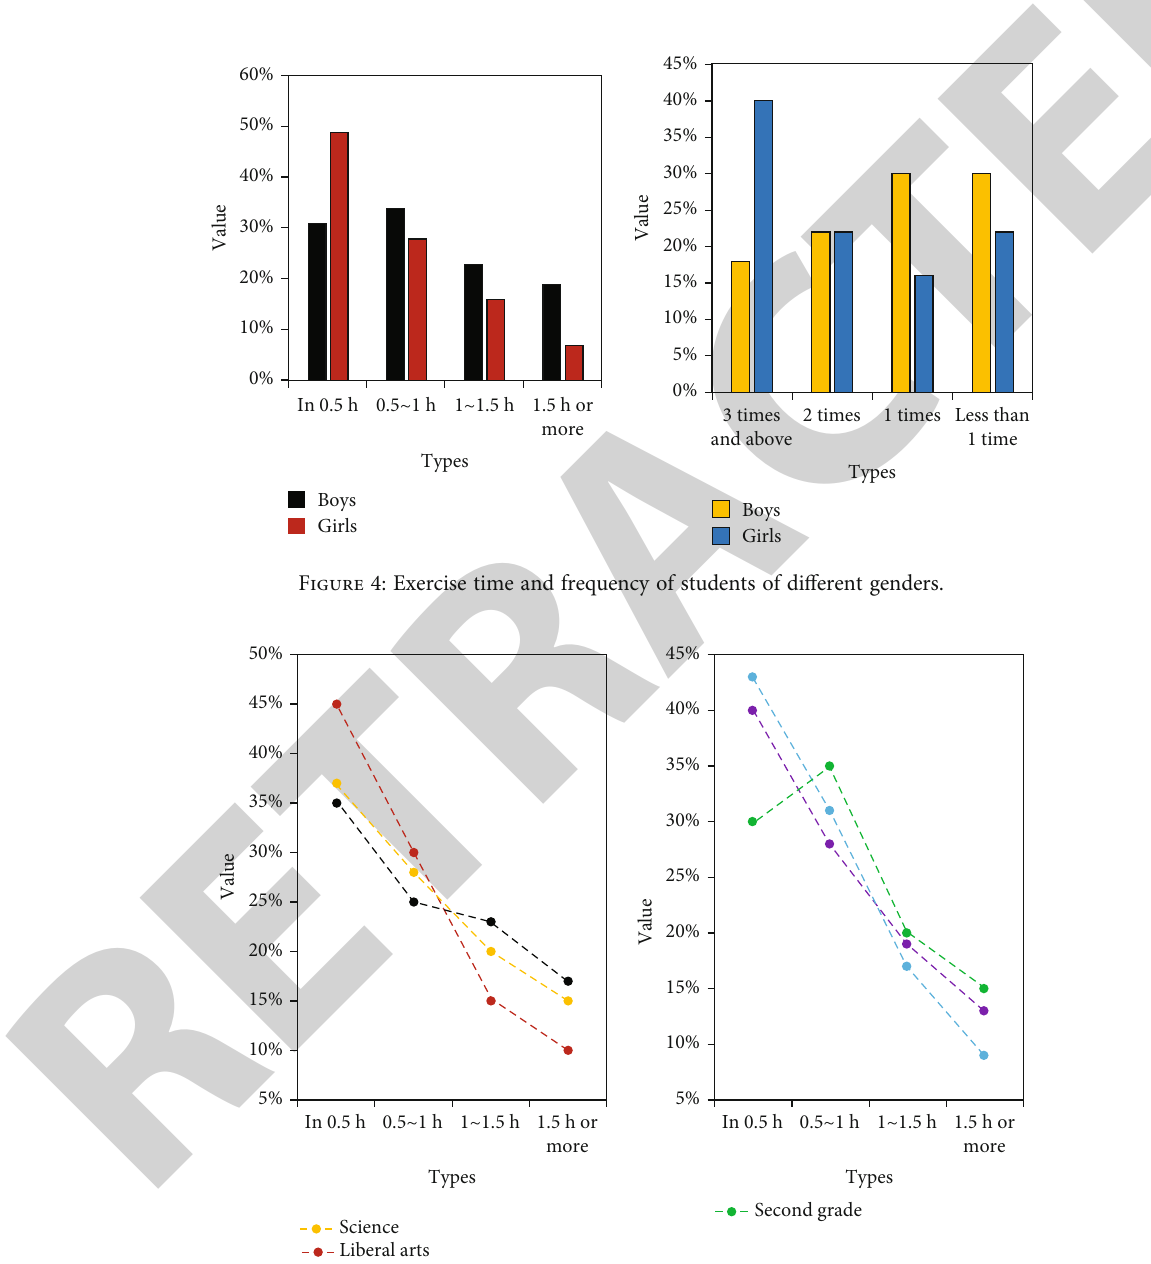
Figure 5: The duration of each exercise for students of di ff erent disciplines and di ff erent